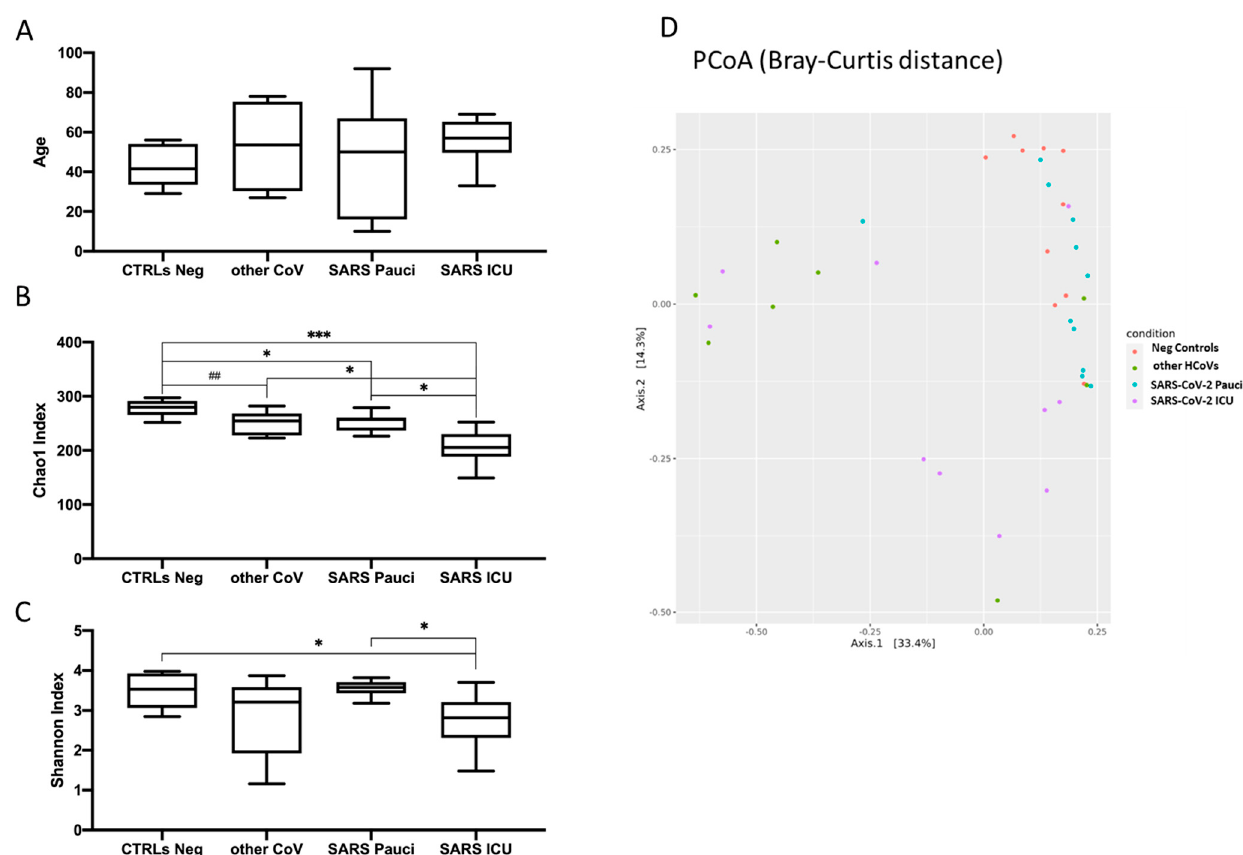
Figure 1. Boxplots of age ( A ), Chao1 index of species richness ( B ) and Shannon index of species diversity ( C ) in healthy subjects (Neg Controls), patients infected with other human coronaviruses (Other HCoVs), paucisymptomatic patients (SARS-CoV-2 Pauci) and patients in Intensive Care Units (SARS-CoV-2 ICU). (## = p < 0.10; * = p < 0.05; ** = p < 0.01; *** = p < 0.005). ( D ) Multidimensional Scaling plot from Principal Coordinates Analysis (PCoA) based on Bray–Curtis distances at genus level showing a clustering pattern among samples obtained from Neg controls (red), other HCoVs (green), SARS-CoV-2 Pauci (blue) and SARS-CoV-2 ICU (violet).